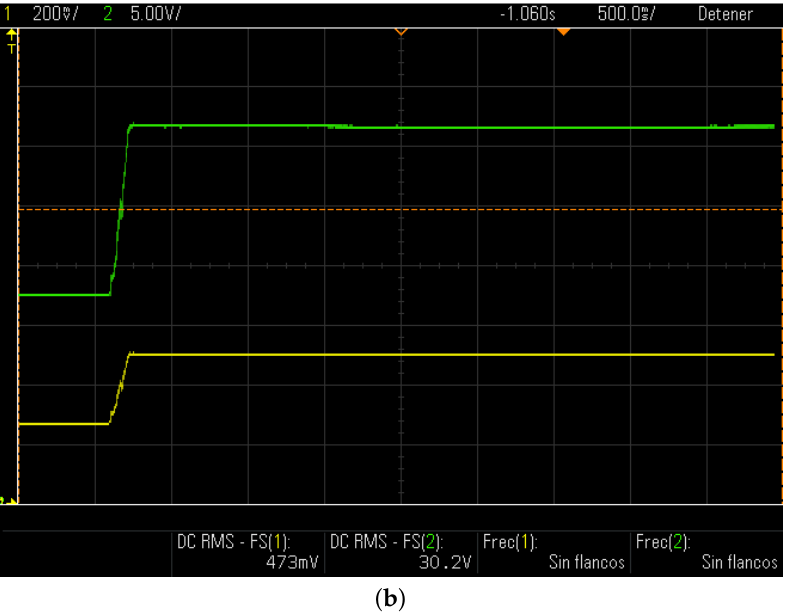
Figure 10. Effective regulation of synthesized non-integer order PID controller. ( a ) Voltage regulation (top line) in the presence of load variation (bottom line). ( b ) Tracking characteristics of the output voltage (top line) for reference changes (bottom